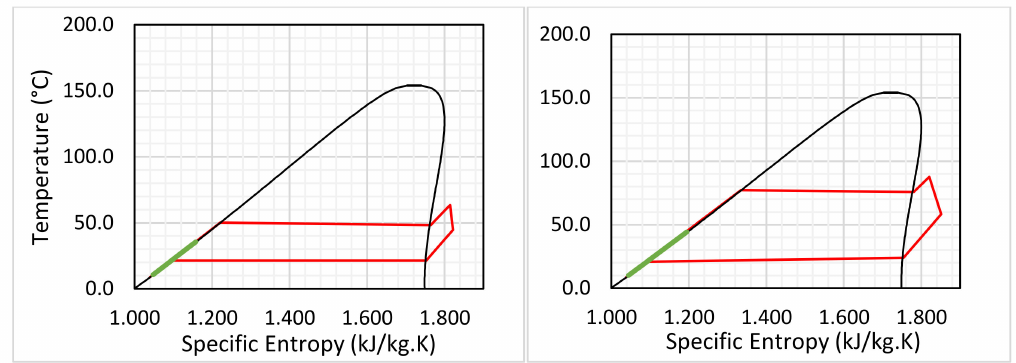
Figure 12. Comparison of T-s diagrams for heat source temperatures of 65 ◦ C (left) and 95 ◦ C (right).